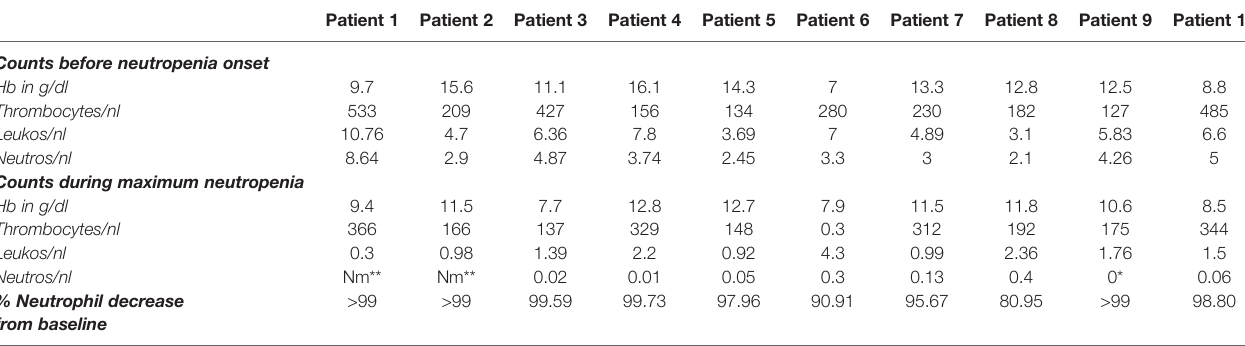
TABLE 3 | Blood counts before neutropenia onset and during maximum irNeutropenia.